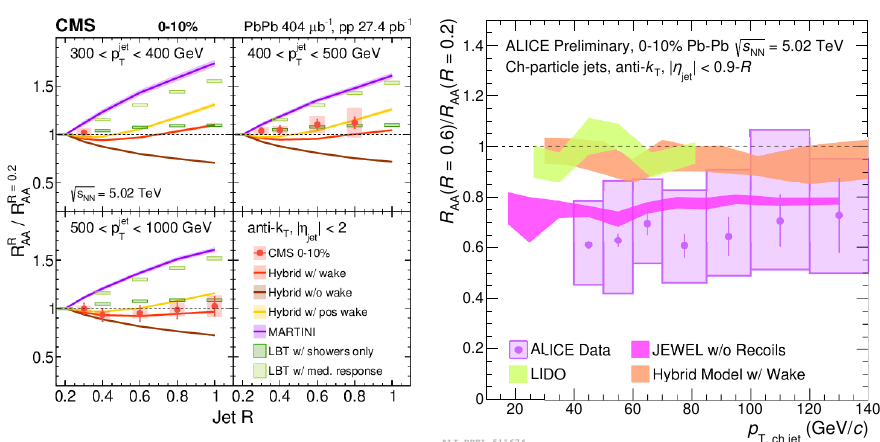
Figure 1. Left: Ratios of the nuclear modification factor R AA for di ff erent jet radii R , in p jet 300-400 GeV / c , 400-500 GeV / c and 500-1000 GeV / c , measured by CMS in central 0-10% Pb–Pb collisions [3]. Right: The ratio of the nuclear modification factor R AA ( R = 0 . 6) / R AA ( R = 0 . 2), measured by ALICE in central 0-10% Pb–Pb